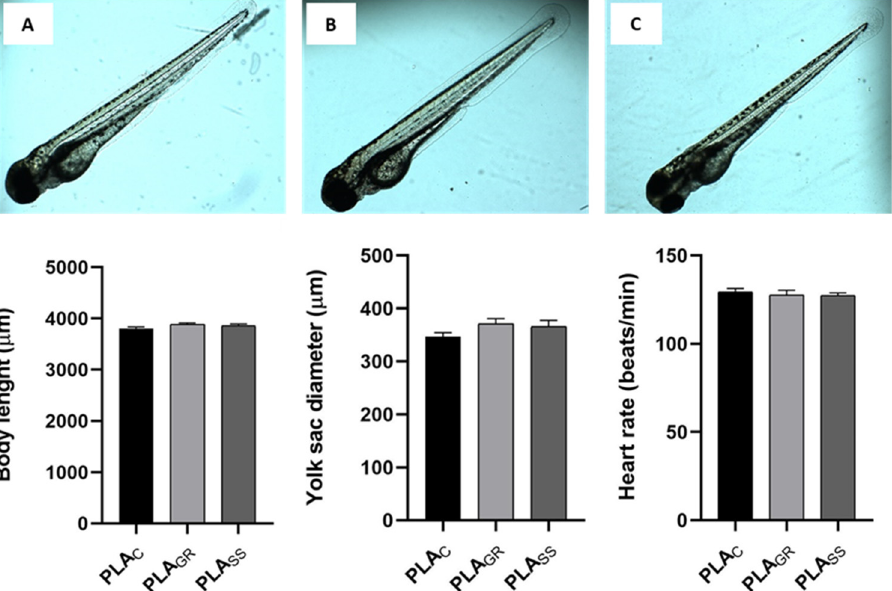
Figure 11. ( A – C ): Images of normal body shape morphology of 72 hpf larvae after exposure to PLA C , PLA GR and PLA SS . Body length, yolk sac diameter and heart rate of 72 hpf larvae after exposure to PLA C , PLA GR and PLA SS . Results are represented as the mean ± standard error.